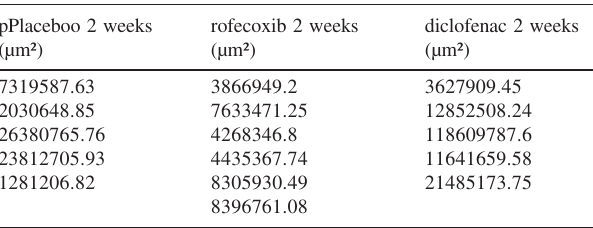
Table 4 - Intragroup comparison of bone neoformation area related to the time of sacrifice (2 vs 4 weeks after osteotomy)